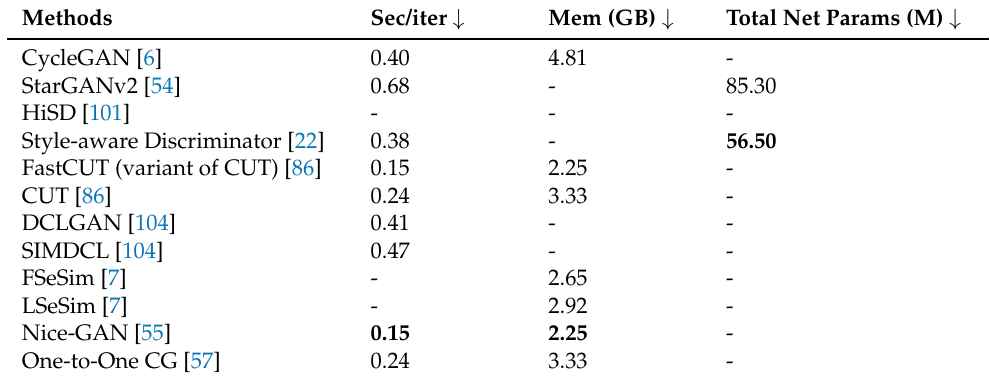
Table 3. Performance aggregation of reviewed papers. Bold numbers are the results of the best performing models in a given metric. Results taken from papers and “-” indicates that no results have been found. Results taken from